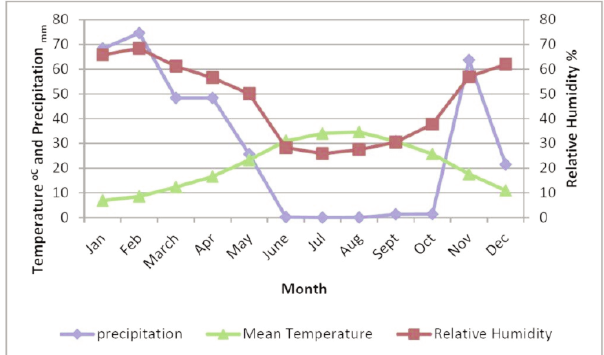
Fig. 1 - Precipitation, mean temperature and relative humidity during five years of experiment. Table 2 - Physical and chemical soil characteristics Particle-size Soil depth distribution (%) (cm)